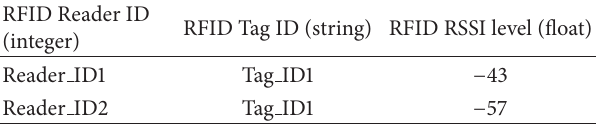
Table 4: Output table of the RFID Reader and Tag Service.